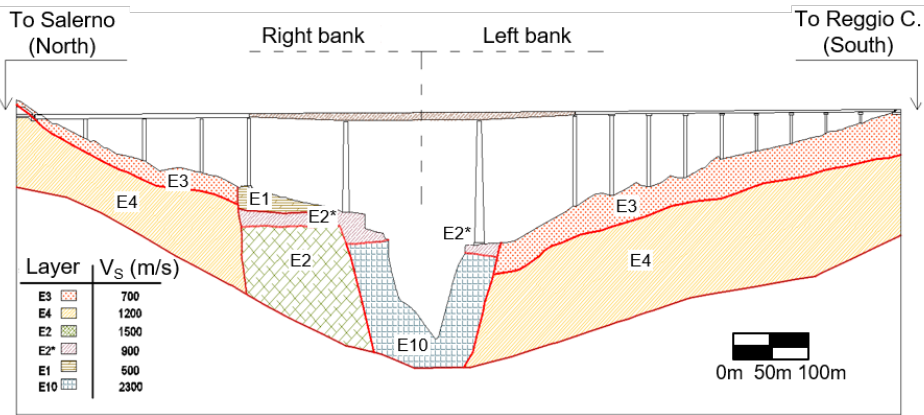
Figure 7. Final geotechnical model obtained by critically merging all available information and